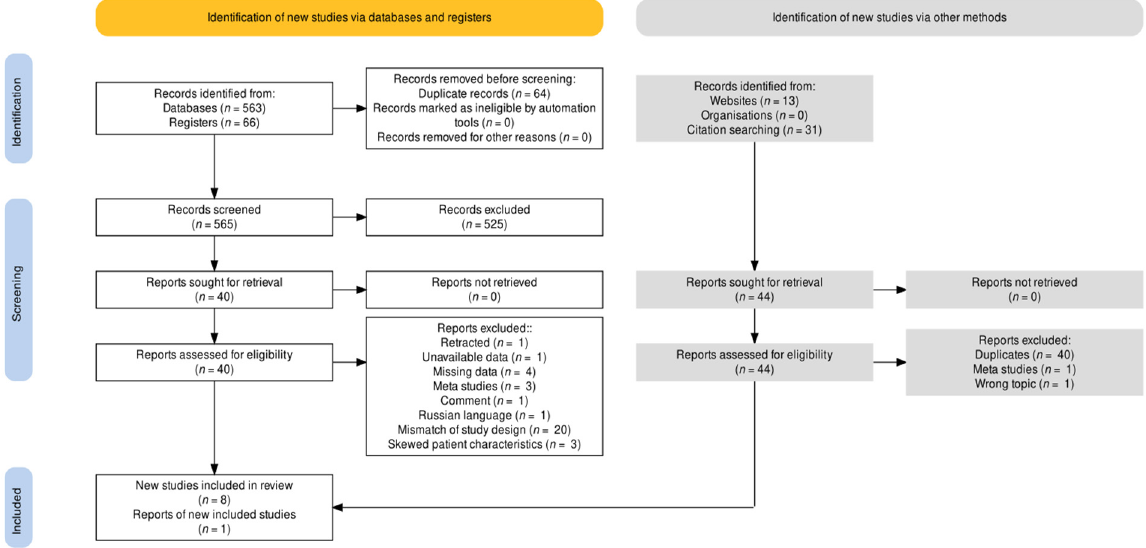
Figure 3. Flowchart of the search strategy and selection process [158].